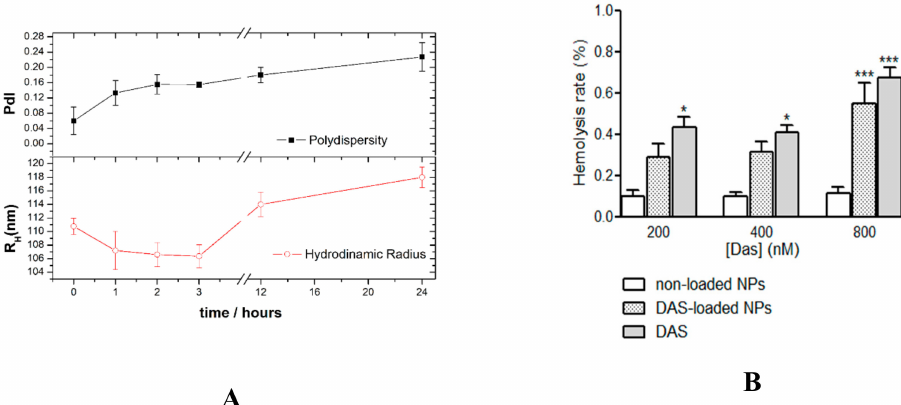
Figure 5. ( A ). Variation of hydrodynamic radio (R H ) and polydispersity index (PdI) with the incubation time for DAS-loaded CHO / PA NPs. ( B ). Blood compatibility of CHO / PA NPs and DAS-loaded CHO / PA NPs. Data are expressed as mean ± s.e.m. from at least three independent